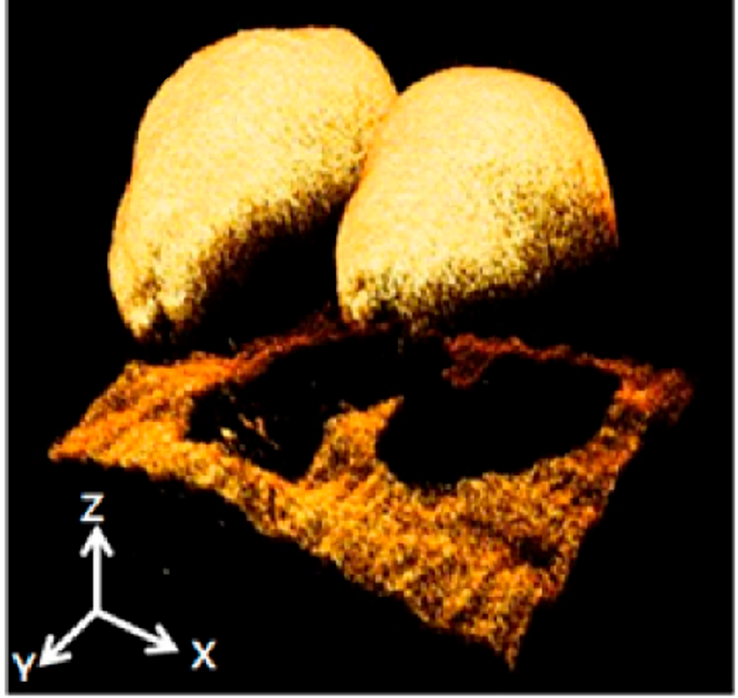
Figure 7. 3-D reconstruction of melon seeds based on interferometry (reproduced from [115]).